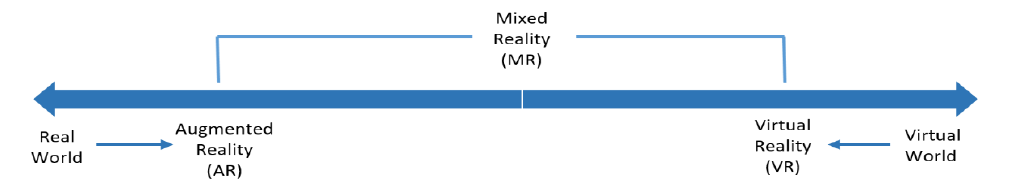
Figure 1. The Milgram and Kishino Reality-Virtuality Continuum.